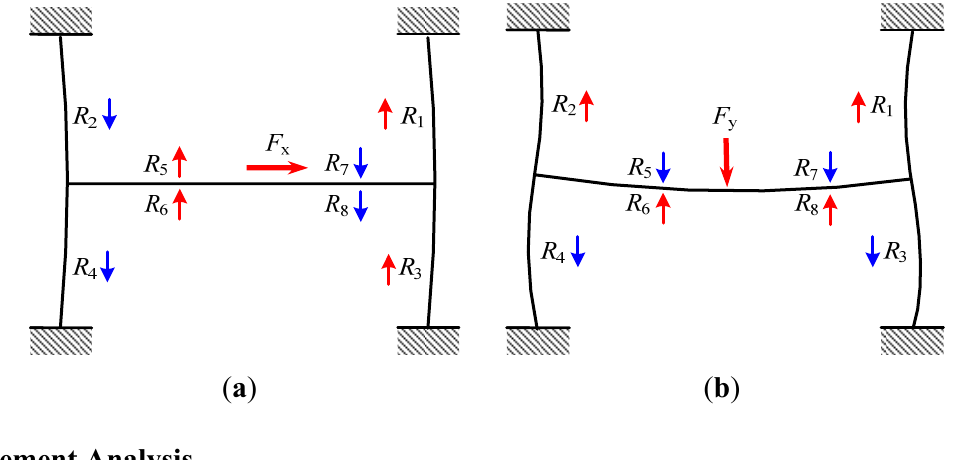
Figure 3. Deformation diagrams of the elastic body under ( a ) lateral load F ( b ) normal load F y